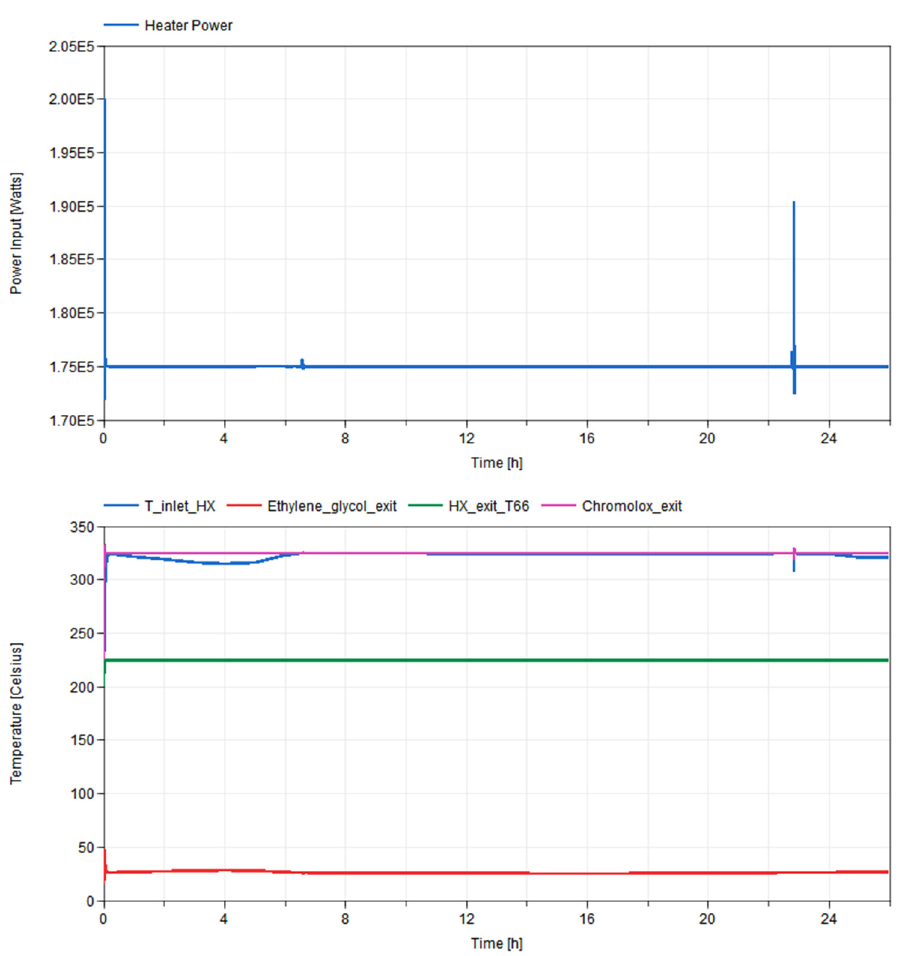
Figure 15. Hot-Summer-Day Scenario: ( Top ) Chromalox heater input. ( Bottom ) Temperatures throughout the TEDS loop.